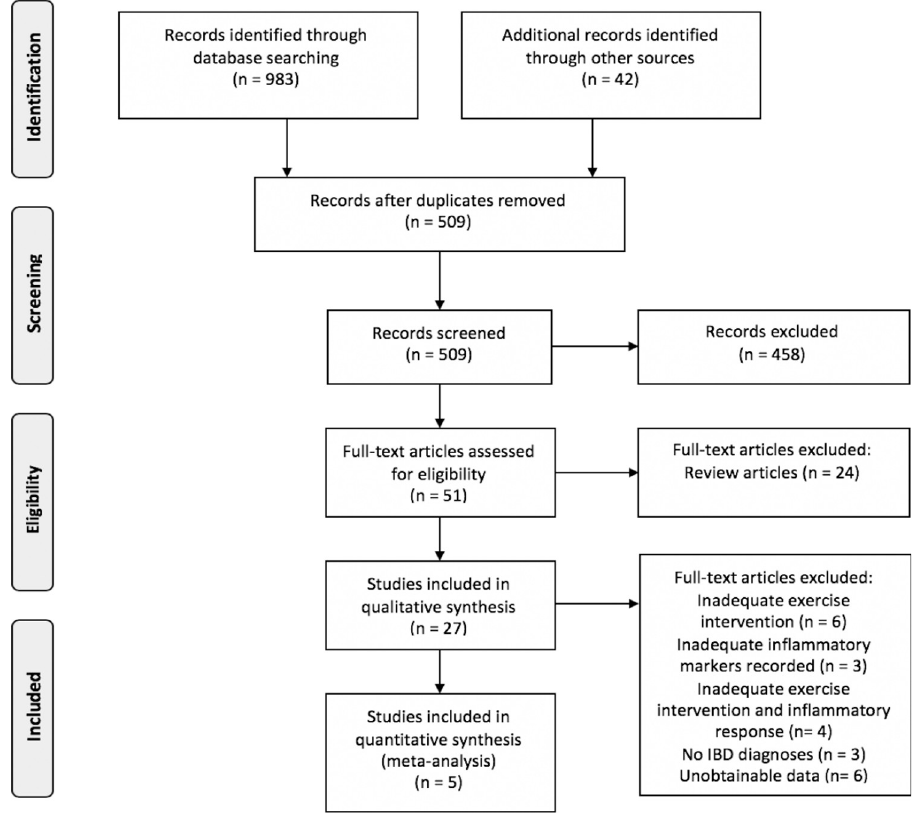
Fig 1. PRISMA (Preferred Reporting Items of Systematic Reviews and Meta–Analysis Protocols) flow diagram. Overview of the identification, screening, eligibility, and inclusion process for the quantitative review.